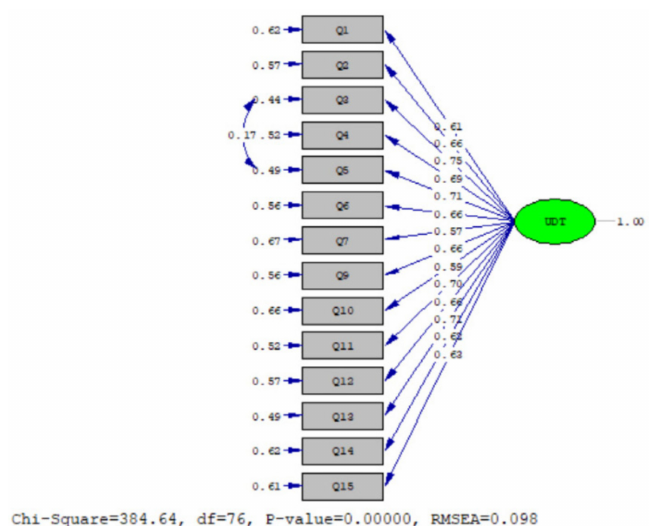
Figure 4. Alternative Model 1.